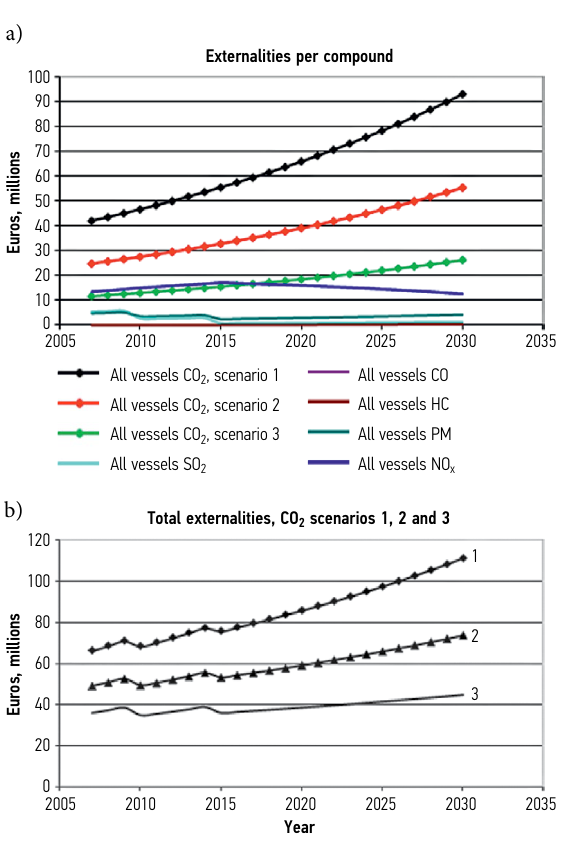
Fig. 2. Externalities: a – externalities (millions of €) of all Fig. 3. Externalities: a – NO x externalities (millions of €) vessels calculated for each compound and for three separate calculated applying different rates of renewal and traffic CO 2 scenarios (cost of t CO 2 as Scenario 1: €32, Scenario 2: growth (%); b – PM and SO 2 externalities shown with a €19 and Scenario 3: €9); b – total externalities (in millions of varying annual rate of traffic growth €) for three CO 2 scenarios